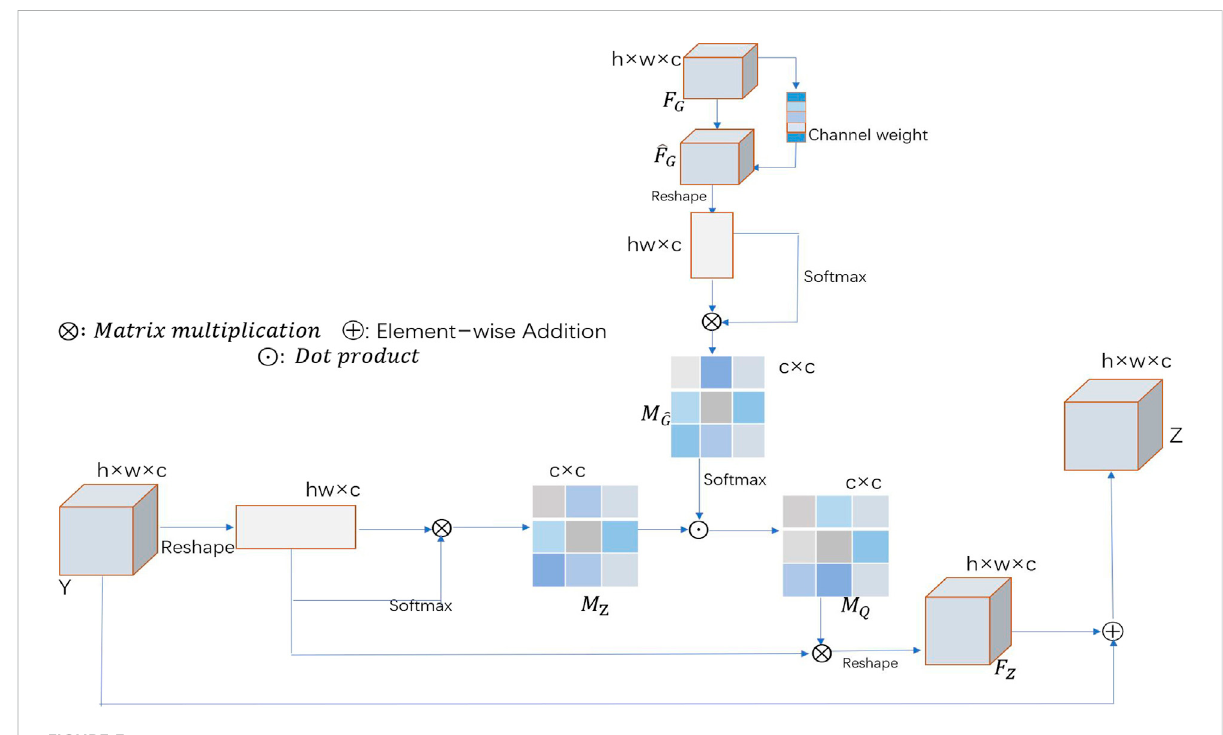
FIGURE 3 Schematic illustration of the channel-wise GGB, where F G is the guidance map and Y is the input feature